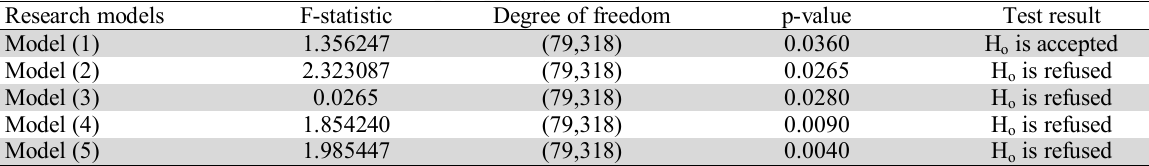
The results of F-Lamer test for intercept equality Research